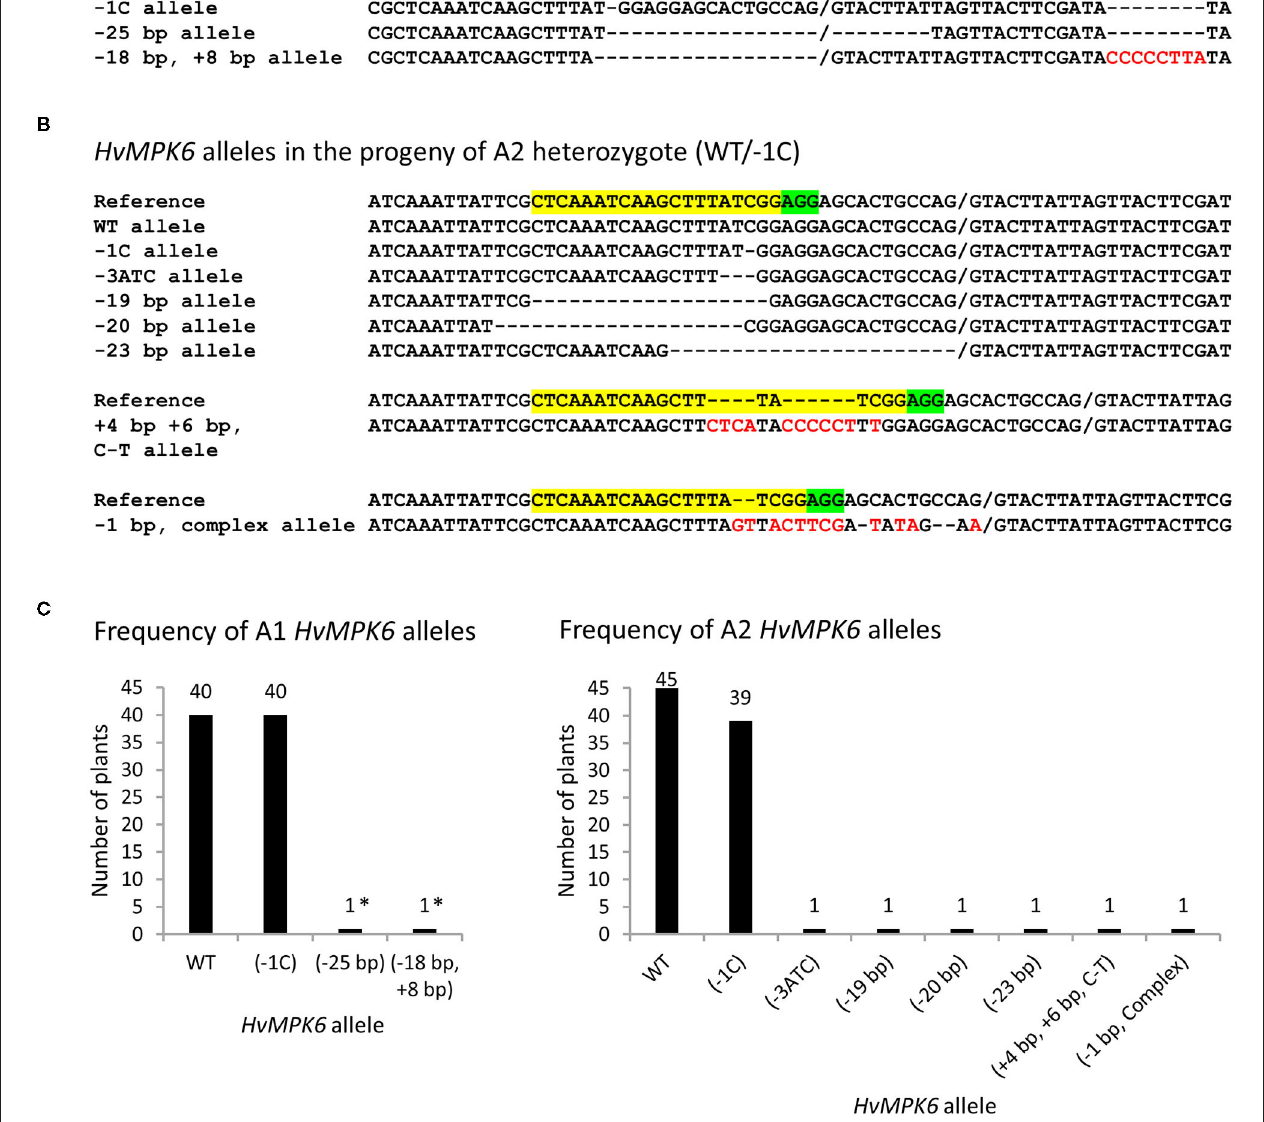
FIGURE 4 | HvMPK6 alleles of the mutated emerged T2 progeny plants of WT/ − 1C heterozygotes. Genomic DNA for the mutation analysis was extracted from the leaves of the transgenic plants. Superimposed sequencing chromatograms associated with heterozygous or chimeric plants were decoded into allelic sequences by using the DSDecodeM tool, cloning of about 316-bp PCR amplicons, and occasionally manual decoding. (A) Nucleotide sequences of the HvMPK6 alleles identified in the progeny of A1 heterozygous mutant (WT/ − 1C). (B) Nucleotide sequences of the HvMPK6 alleles indentified in the progeny of A2 heterozygous mutant (WT/ − 1C). The selected nucleotide sequence region of the WT HvMPK6 allele is shown as a reference on the top of each multiple sequence alignment with the gRNA on-target site and the PAM site highlighted in yellow and green, respectively. Slash indicates exon/intron boundary and dash indicates single nucleotide deletion. Inserted or changed nucleotides are typed in red. Designation of an allele is shown on the left of each sequence. Minus indicates deletion, plus indicates insertion, and bp indicates base pair. Note that the − 25 bp, − 18 bp + 8 bp, and − 23 bp mutations eliminated the splicing site between the exon 3 and intron 4. (C) Frequency of the HvMPK6 alleles in the mutated progeny plants of A1 (WT/ − 1C) and A2 (WT/ − 1C) heterozygotes. Absolute numbers of individual alleles are plotted and shown above each bar chart. In total, 40 and 45 mutated A1 and A2 plants, respectively, were identified and all of them contained WT allele. Among mutated alleles, the − 1C Hvmpk6 allele was prevalent and others were rare. Nearly all mutated plants were heterozygotes of WT and − 1C allele. Two A1 plants were chimeras and harbored − 25bp or − 18bp, + 8bp allele (indicated with asterisks) in addition to the WT and − 1C allele.